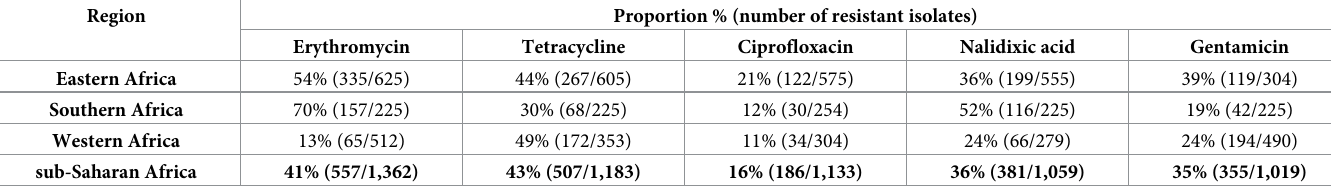
Table 4. Summary of human Campylobacter spp. resistant isolates to the most tested antibiotics.